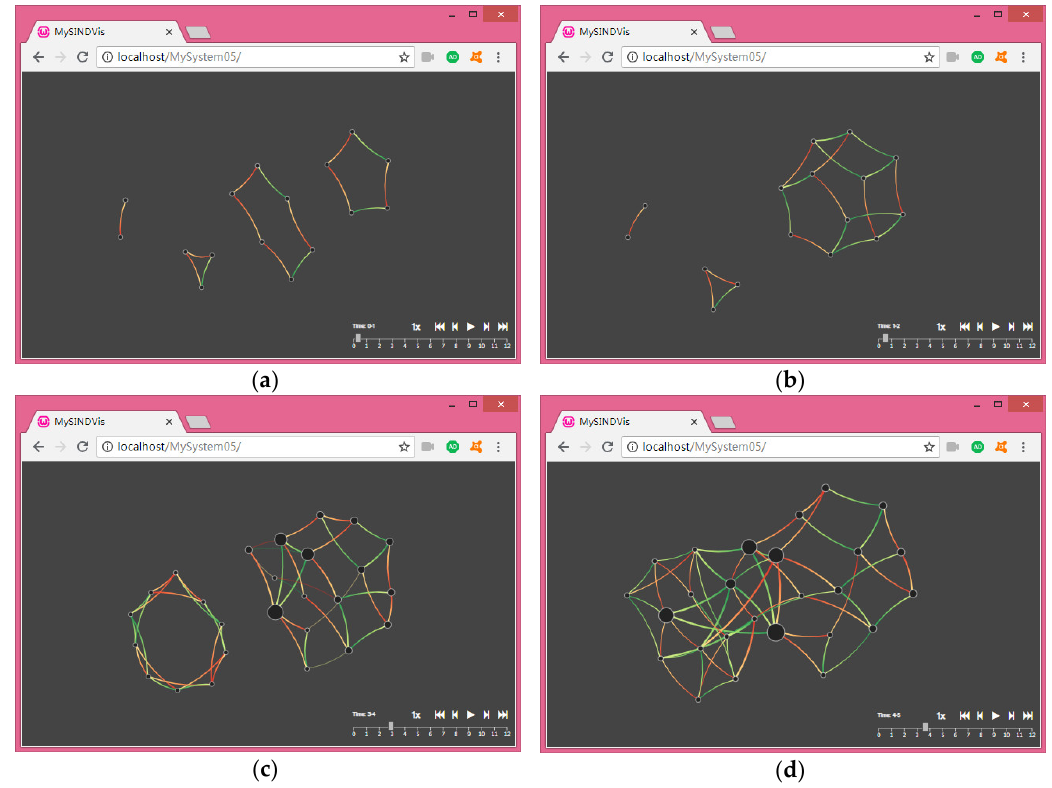
Figure 16. The process displays of dynamic networking of SIN: ( a ) The basic elements of SIN at the initial moment; ( b ) the formation process of the MEO/LEO-layer satellite system; ( c ) the formation process of satellite systems; ( d ) the process of prototype formation of SIN.